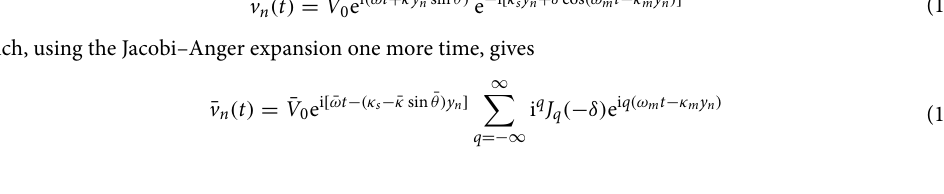
20 . The white dotted lines indicate δ =